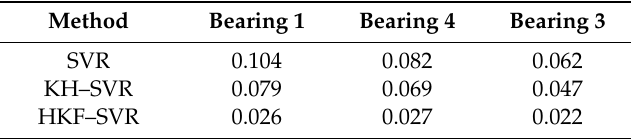
Table 4. Prediction errors